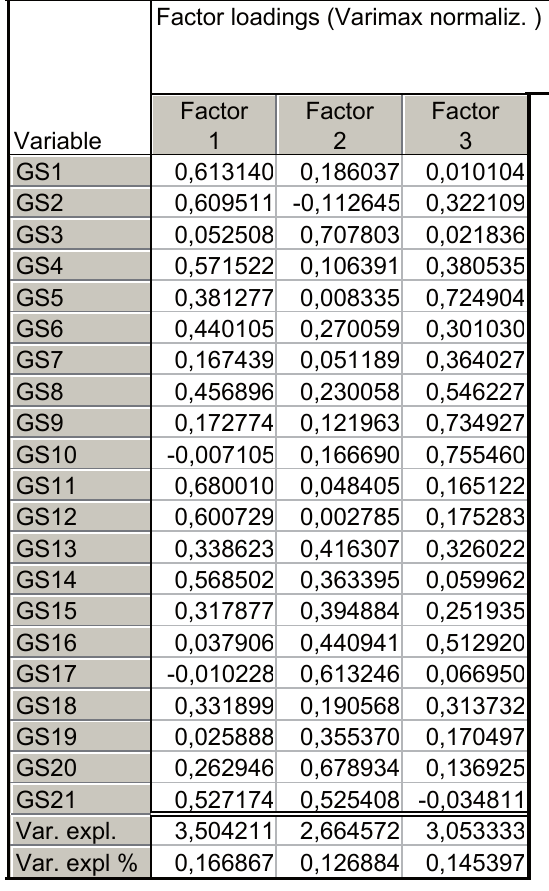
Table 3: Factor analysis of gender stereotypes